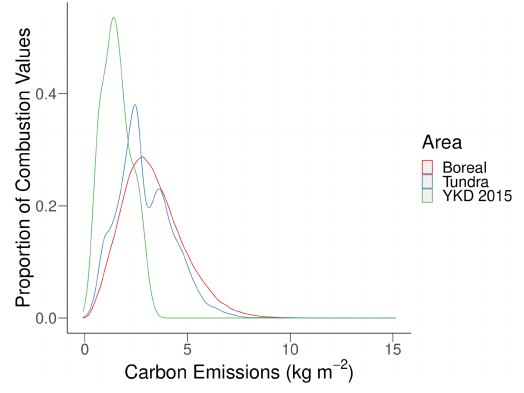
Figure A9. The distribution of carbon emission values from transect measurements in the YKD 2015 fires reported herein and from remotely sensed pixels of all fires in boreal and tundra systems in Alaska between the years 2001 and 2018 (Scholten et al., 2021).